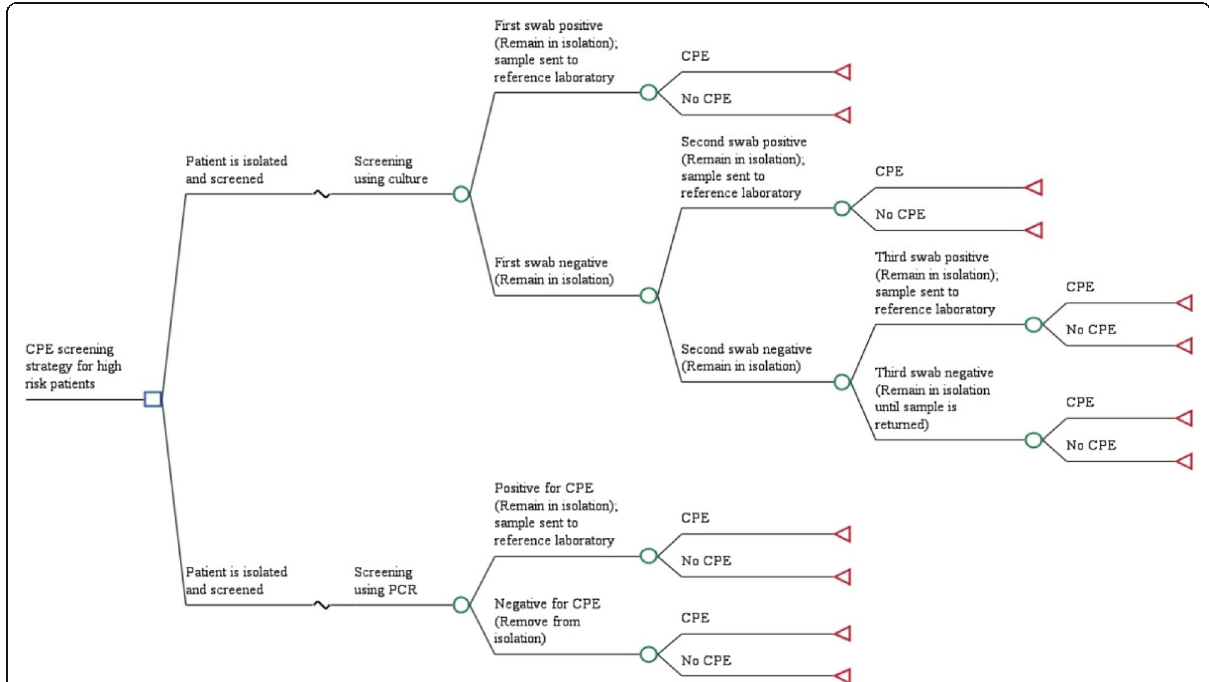
Fig. 1 Decision tree to assess costs and consequences of PCR testing for CPE compared with culture testing for